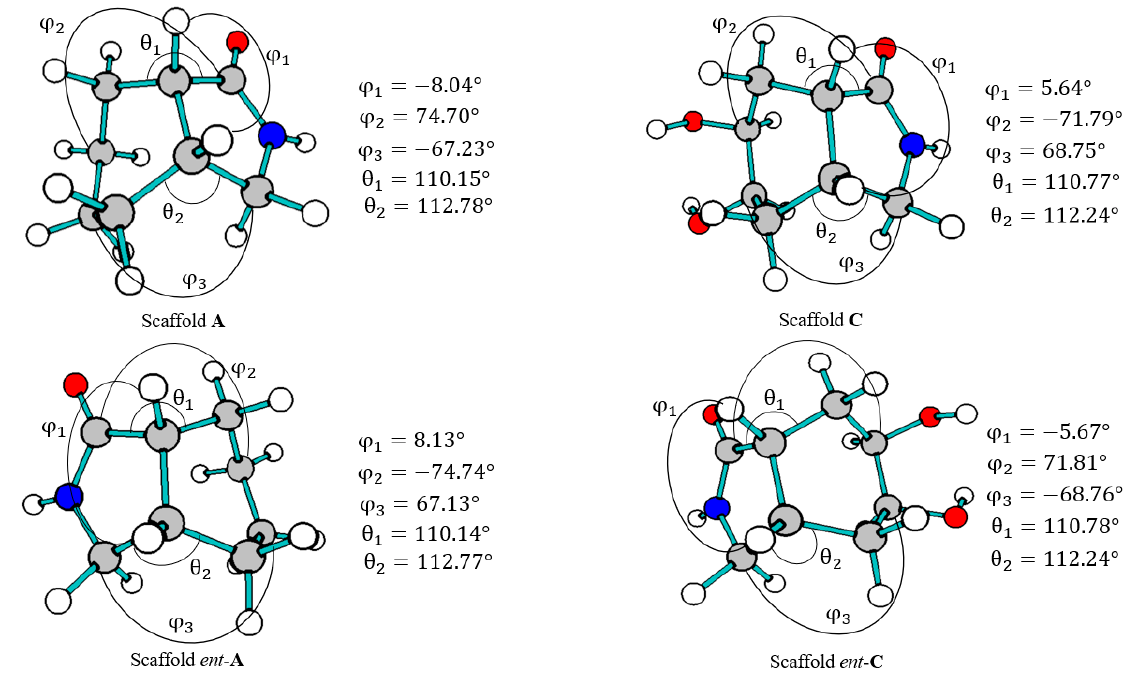
Figure 7. Values for dihedral angles: ϕ 1 (H-3a-7a-H), ϕ 2 (C6-C7-C7a-C1) and ϕ 3 (C5-C4-C3a-C3) and θ fused ring angles of each scaffold conformer, similar to the allosamizoline moiety and the oxazolinium ion fragment.